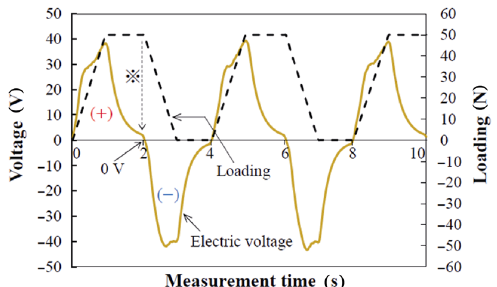
Fig. 2 Voltage generated by PZT ceramic and mechanical loading of PZT ceramic as a function of time.